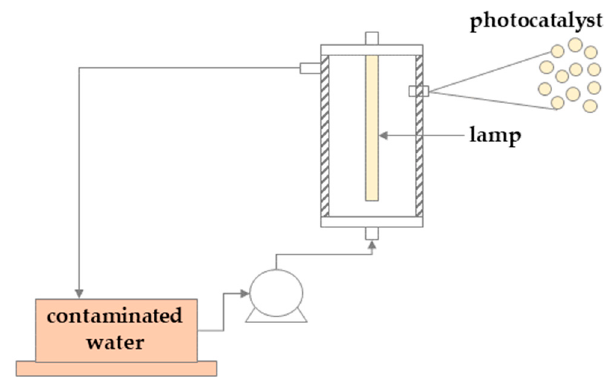
Figure 5. Simplified scheme of a photocatalytic system with a photocatalyst immobilized on the Figure 5. Simpli fi ed scheme of a photocatalytic system with a photocatalyst immobilized on the photoreactor wall. photoreactor wall.